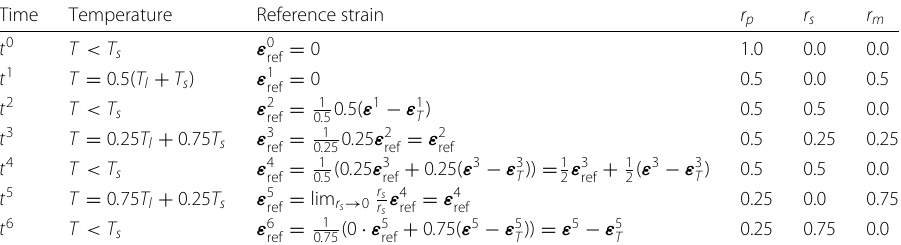
Table 3 Exemplary evolution of reference strain for repeated cooling and heating assuming constant strains during solidification Time Temperature Reference strain r p r s r m t 0 T < T s